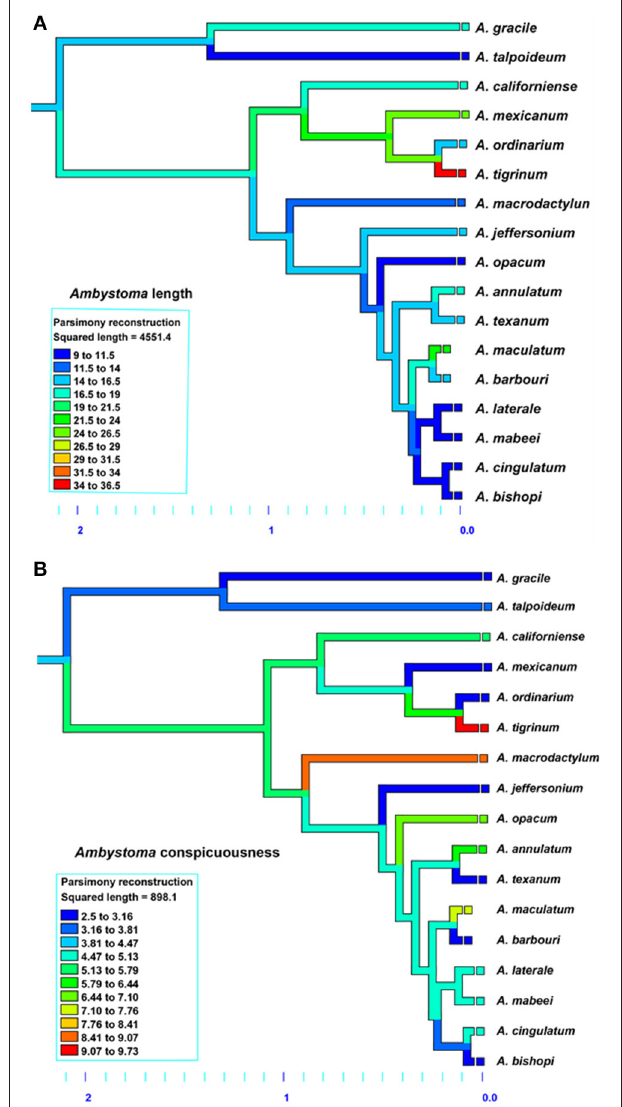
FIGURE 3 | Evolution of (A) average total length and (B) conspicuous coloration in Ambystoma salamanders using the squared-change parsimony Mesquite version 2.75. Orange and red shades represent a larger body size (top) and more conspicuous coloration (bottom). Phylogeny adapted from Williams et al.